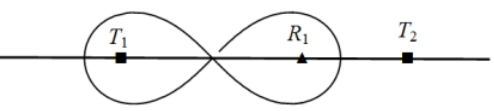
Figure 9. Maximum placement spacing of heterogeneous BR sequence T 1 − R n − T 2 when n = 1. At this point, (cid:107) T 1 R 1 (cid:107) = d 1 . However, because the physical properties of transmitter T 1 and transmitter T 2 are di ff erent, the size of these two coverage areas is di ff erent as well and needs to be